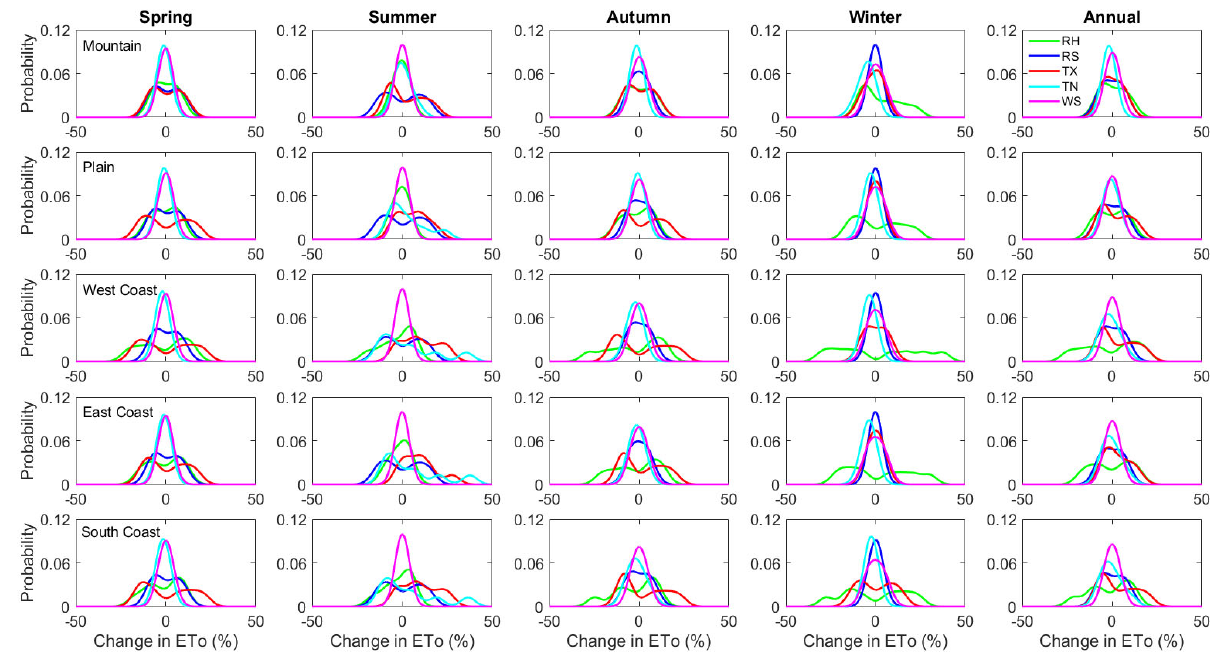
Figure 7. Probability density of changes ET o with respect to changes in meteorological variables on seasonal and annual scales in different geographic conditions.